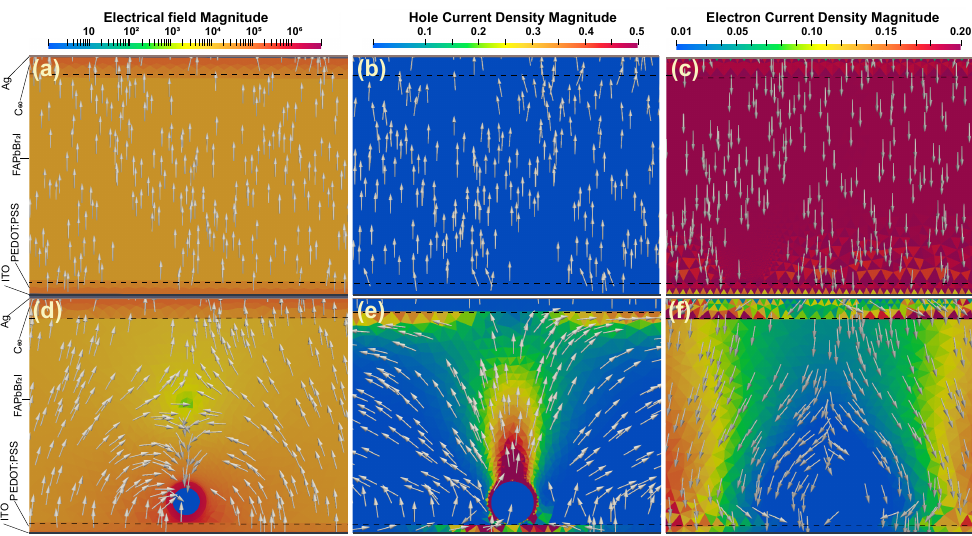
Figure 6. Calculated electrical characteristics of FAPbBr 2 I at 1.5 V: ( a ) electric field, ( b ) hole cur- rent density, ( c ) electric current density distributions, and those with integrated core-shell NP, respectively ( d – f